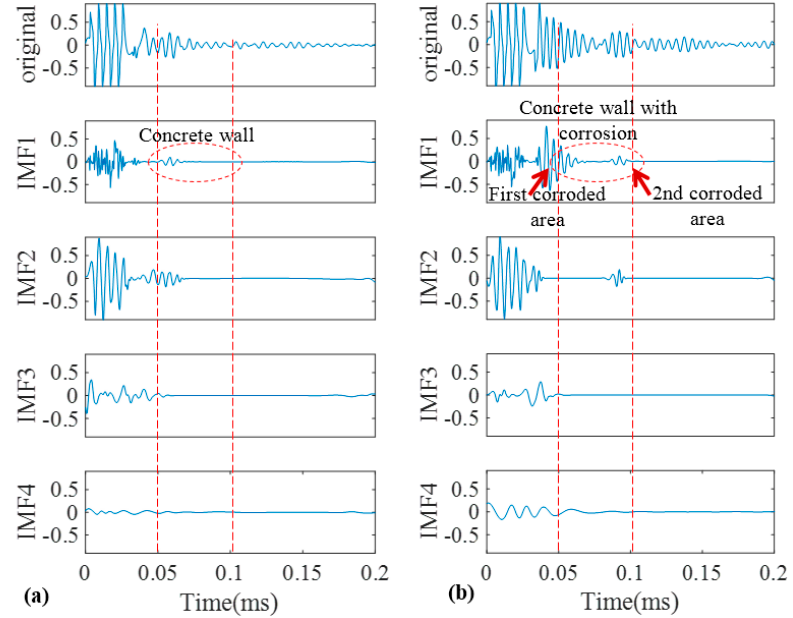
Figure 21. Decomposition of signals into their IMFs by SEMD for the pristine pipe ( a ); and the pipe with a natural corrosion ( b ).